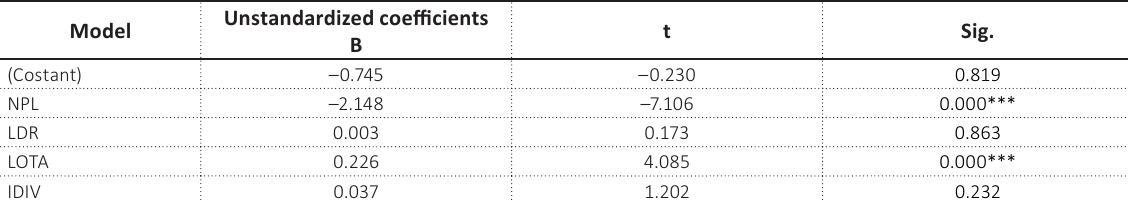
Table 2. Test of regression 1